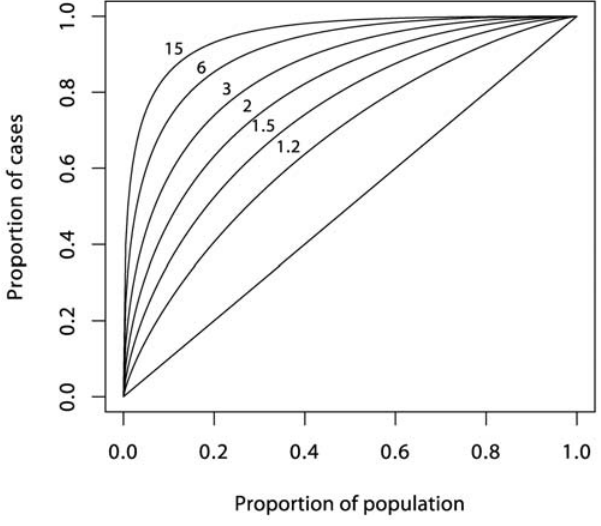
Figure 2. Theoretical ROC curves for various values of l s under the polygenic multiplicative